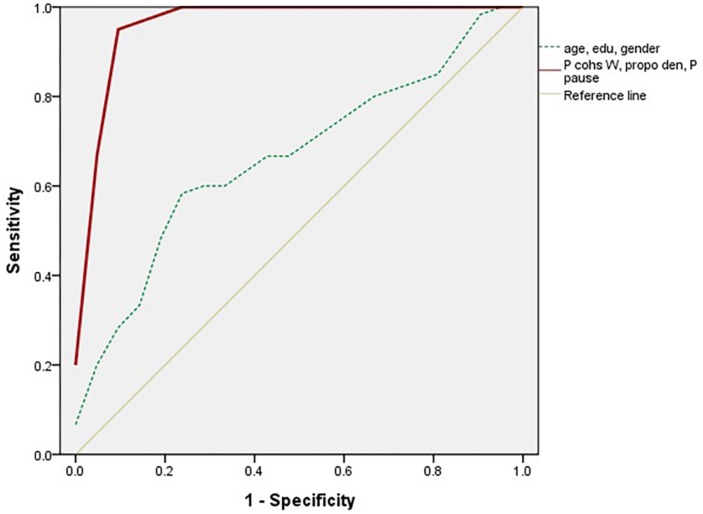
Receiver operating characteristic curve in three influential measures (i.e., the proportion of cohesive words and pauses and propositional density) and controlling variables in aMCI and HC.